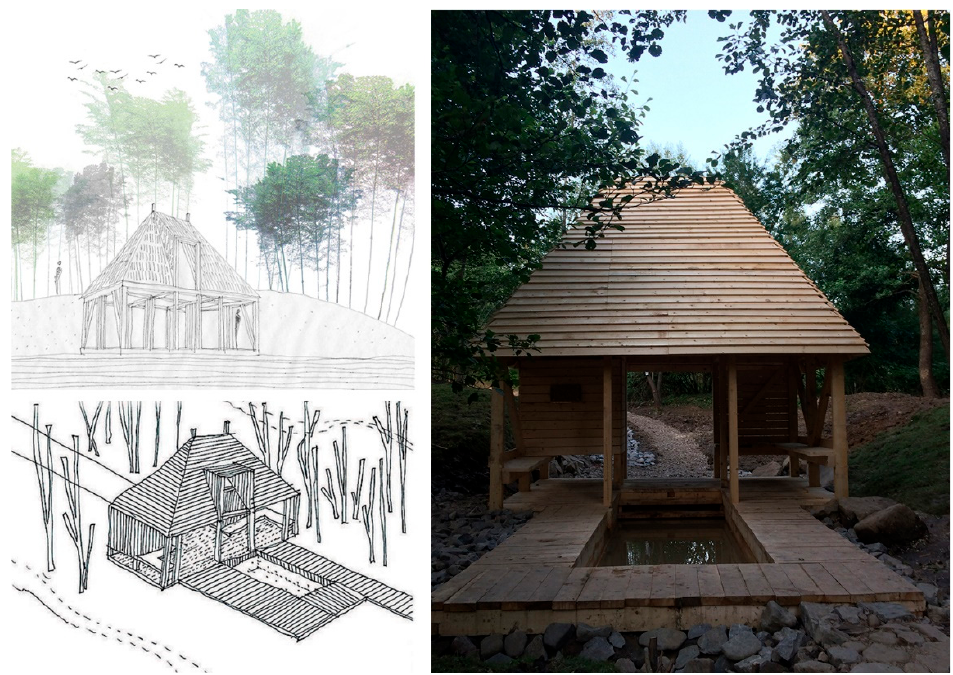
Figure 7. Concept and renewed site of the Csipkés mineral water bath in Zabola (Zabala, Romania), as result of the sustainable strategy for renovation of vernacular baths in 2018. List of designers and contributors on the https://www.arstopia.hu/2018-kalakak-zabola (accessed on 5 December 2021).